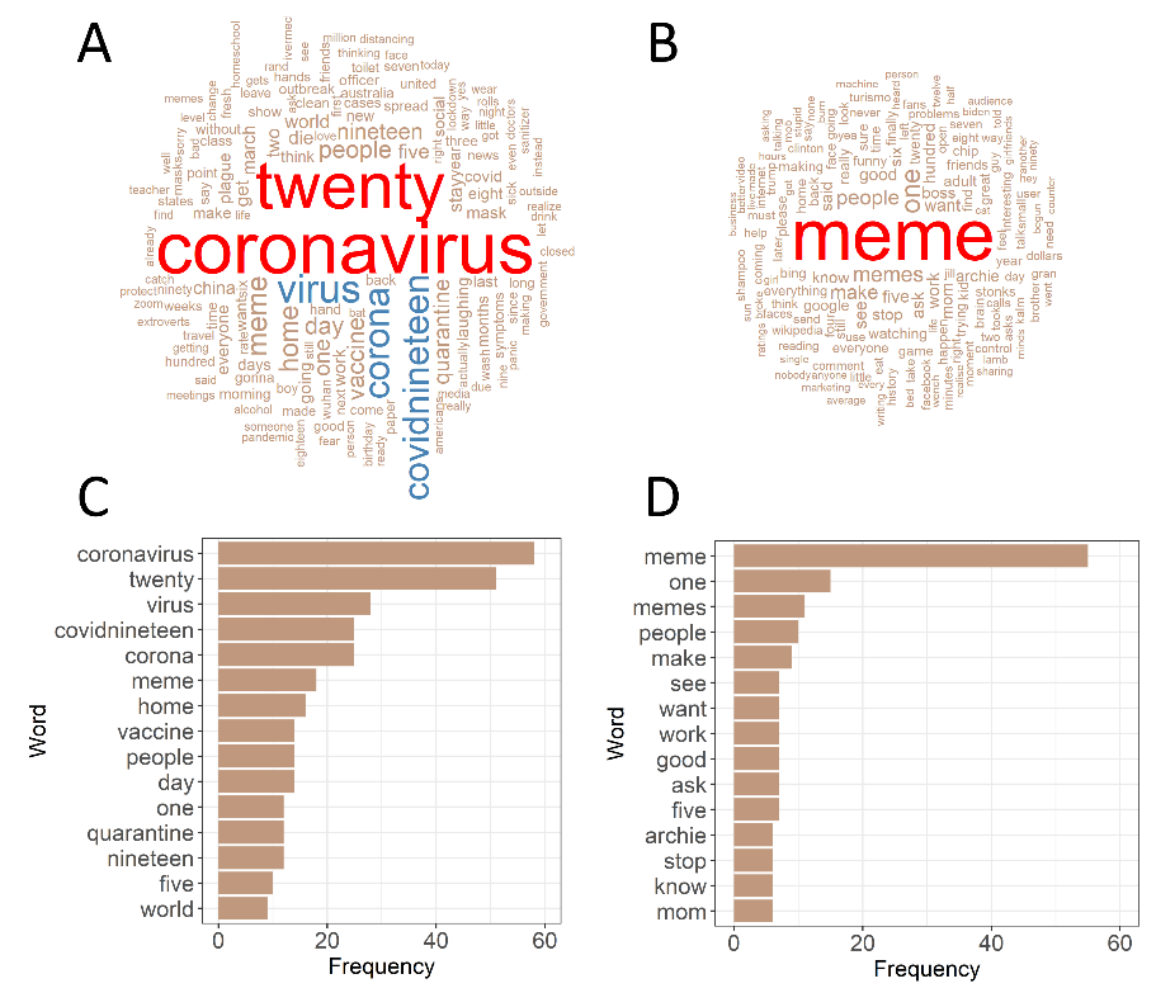
Figure 5. Text mining analysis in coronavirus ( left panel: ( A , C )) and non-coronavirus memes ( right panel: ( B , D )). The size of words in the word clouds was scaled by frequency. The 15 most common words are presented in the lower panel.